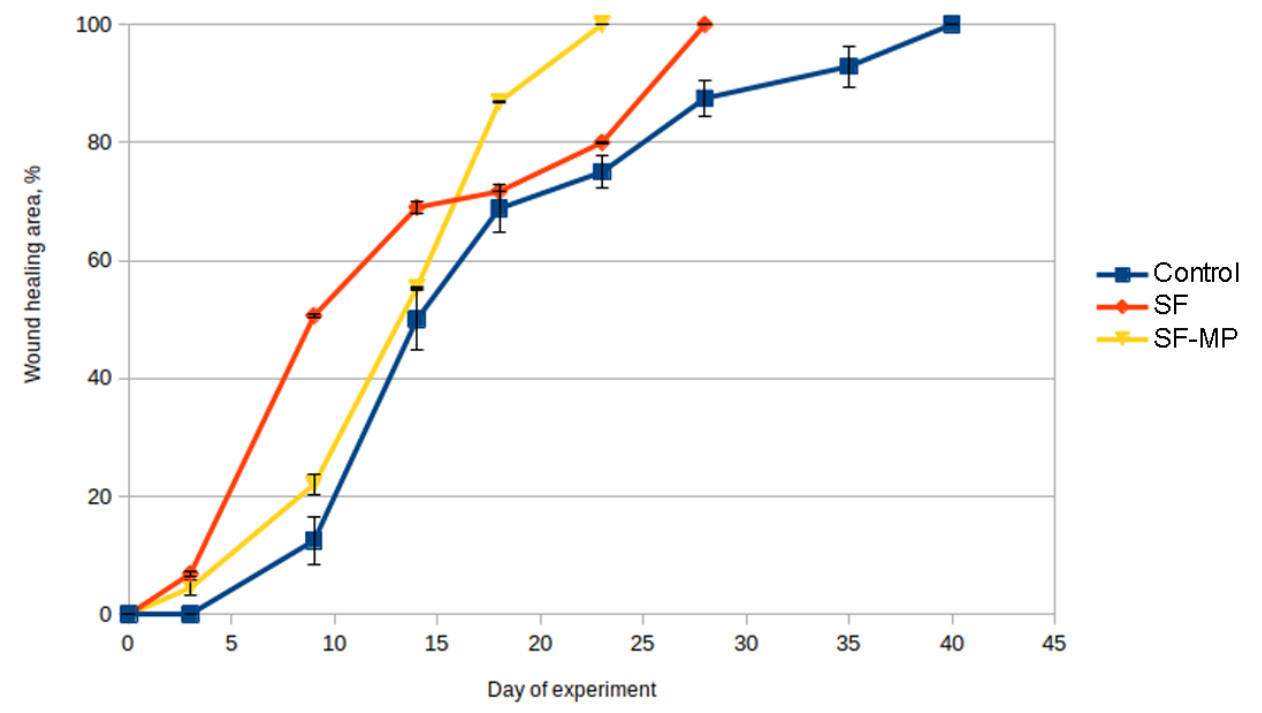
15 of 21 To quantify the wound-healing process, wound diameters were measured on the 0th, 3rd, 9th, 14th, 18th, 23rd, 28th, 35th, and 40th days of the experiment (Table 3), and healing curves were plotted (Figure 12). Table 3. Dynamics of full-thickness skin wound healing in Wistar rats (standard deviation values for five independent measurements are shown).